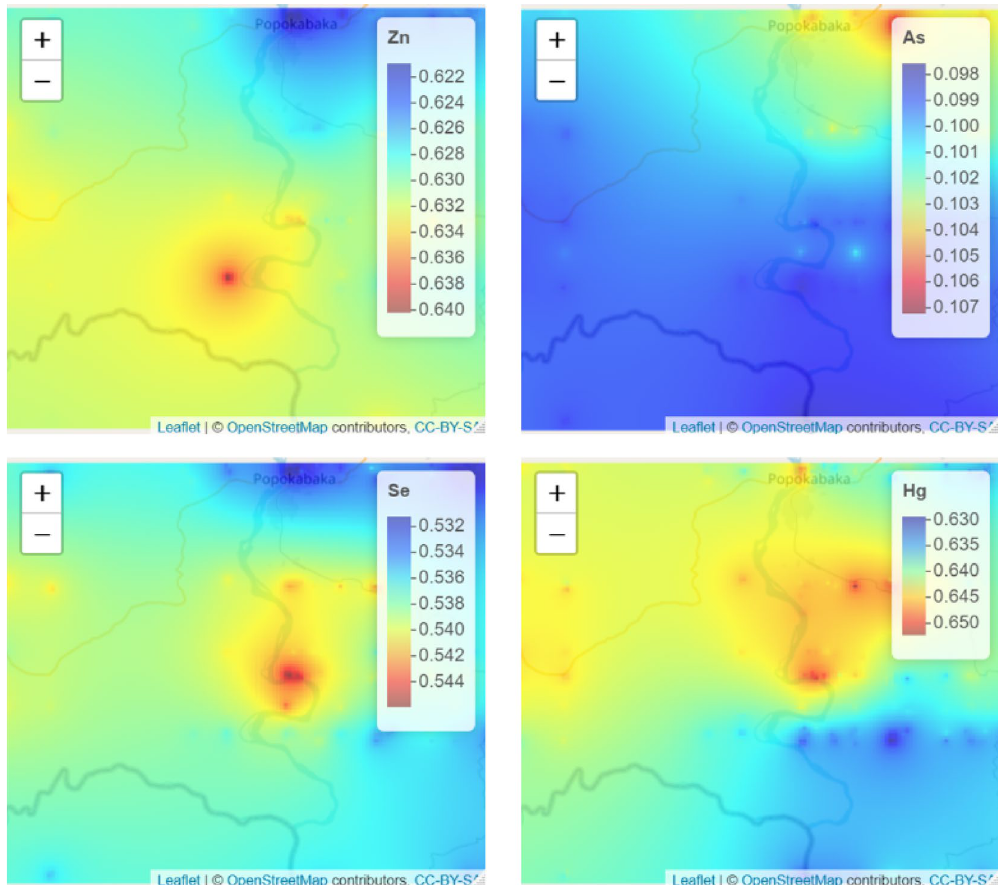
Figure 1. Spatial distribution and variation in As, Zn, Se, and Hg in Popokabaka. For plotting purposes, the concentrations of Se, As, and Hg were multiplied by 10, 100 and 1000, respectively. The inverse distance’s weighting is based on the optimum power obtained after the cross-validation.